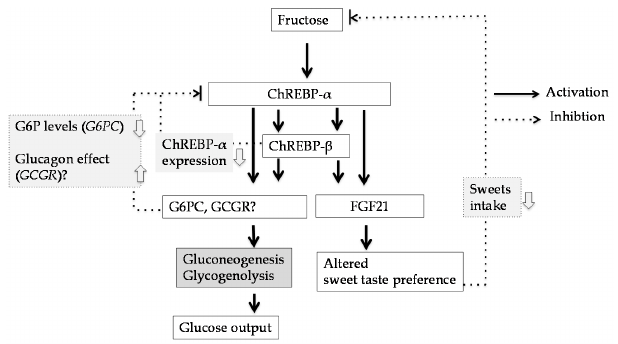
Figure 5. Fructose induces G6pc and Fgf21 gene expression thorugh ChREBP activation. ChREBP ‐α regulates ChREBP target genes expression. In turn, products of ChREBP target genes (ChREBP ‐β , G6pc, Gcgr, and Fgf ‐ 21) might suppress ChREBP transactivity [20–22,67,73]. FGF ‐ 21 suppress ChREBP transactivity by decreasing sweets intake [70,71]. GCGR might suppress ChREBP activity by enhancing glucagon effects and thereby protein kinase A activity. G6PC might suppress ChREBP activity by decreasing intracellular G6P levels. G6PC, glucose ‐ 6 ‐ phosphatase catalytic subunit; GCGR, glucagon receptor; FGF21, fibroblast growth factor ‐ 21; G6P, glucose ‐ 6 ‐ phosphate; ChREBP, carbohydrate response element binding protein.